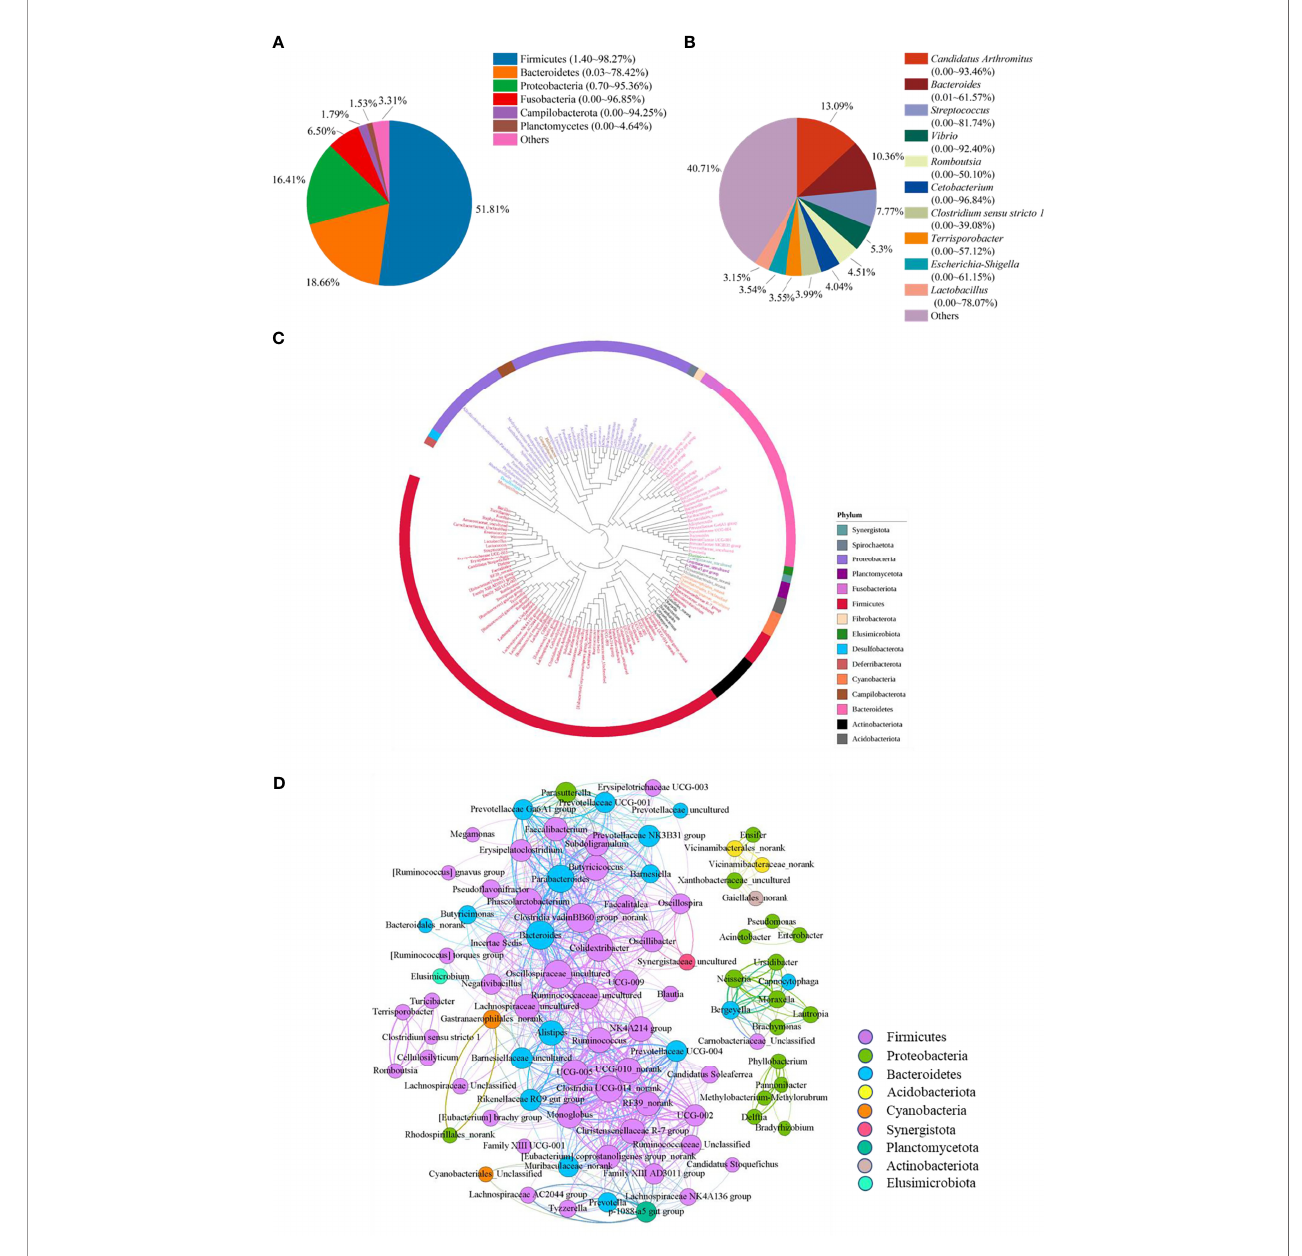
FIGURE 1 | The microbiota composition in the ileum of Muscovy ducks. Two hundred newly hatched ducklings were fed commercial feeds for 70 days before the ileal content samples were collected from each ileum segment. The relative abundance of OTUs was used to determine the bacterial composition at phylum (A) and genus (B) levels with 200 samples. Only the top six phyla and 10 genera are displayed, with unidenti fi ed and lowly abundant bacteria collectively denoted as “ others ” . The phylogenetic tree (C) and co-occurrence pattern (D) of 50% the common bacteria in the ileum of Muscovy ducks. In the phylogenetic tree, the colored strips and labels were colored by the phylum. In the co-occurrence network, the sold line indicated that Spearman ’ s rank correlation coef fi cient > 0.8 with P < 0.001; the size of the node was proportional to the abundance of the genus; the color of the nodes and lines were related to the phylum to which the genus